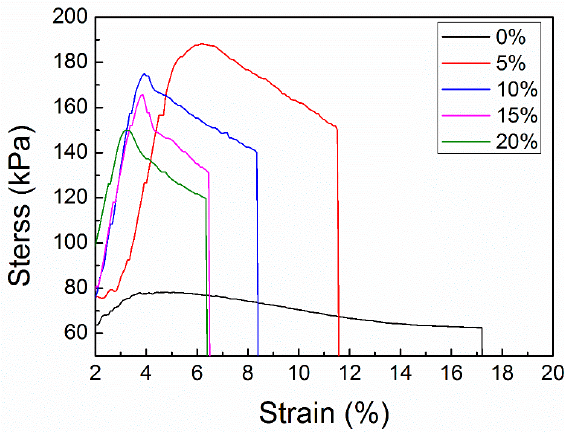
Figure 4. Stress–strain curves of sc -PLA/PMMA nanofiber filter with different contents of sc -PLA.